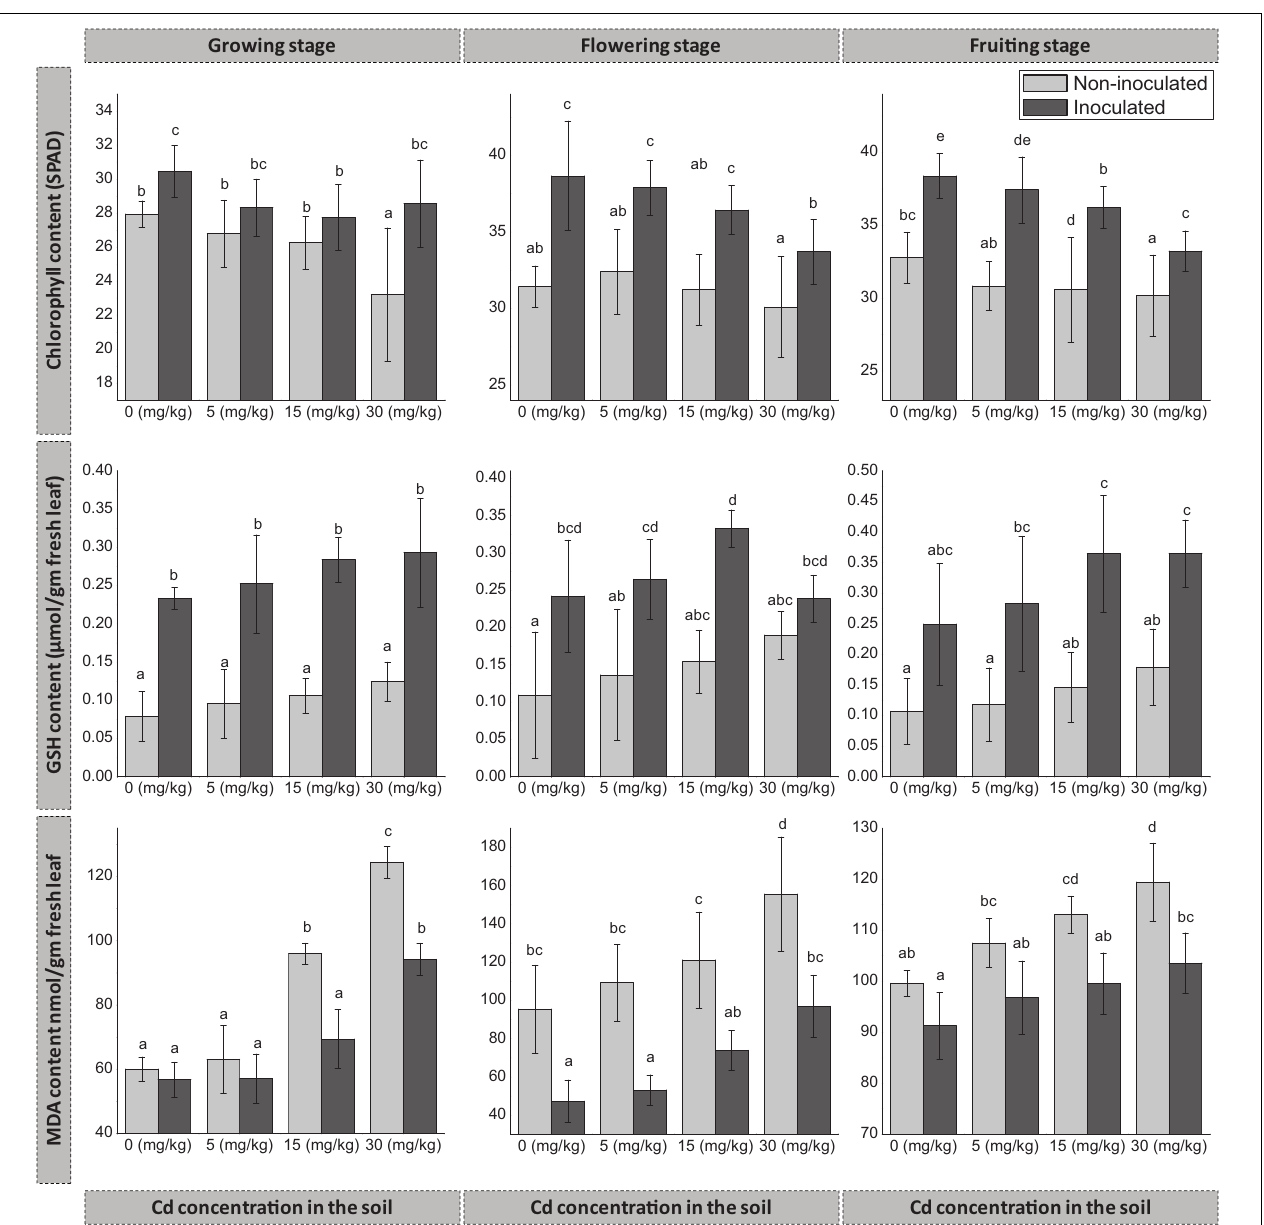
FIGURE 3 | Effects of endophyte FZT214 on the chlorophyll (mean ± STD, n = 9), GSH, and MDA (mean ± STD, n = 3) content of D. ambrosioides grown under different Cd concentrations at different developmental stages. The different lowercase letters indicate significant variation between treatments ( p < 0.05) according to Duncan’s test of one-way